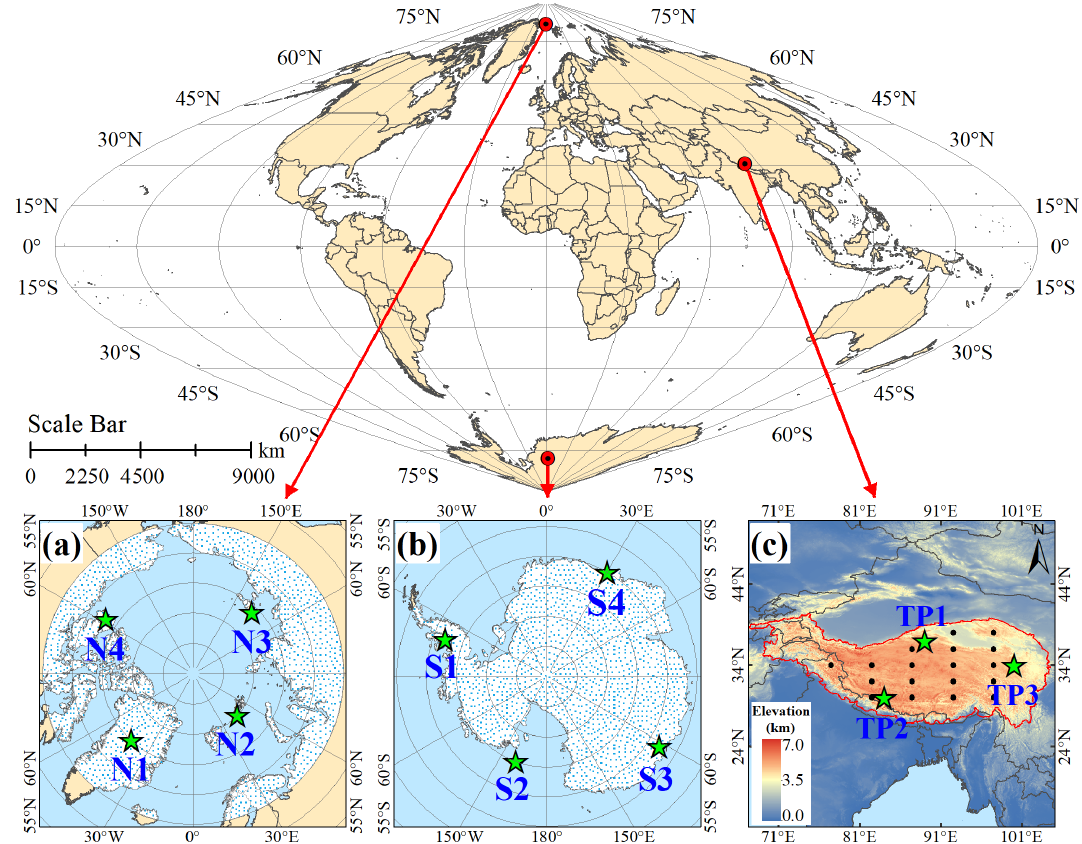
Figure 1. Geographical map of the three study areas: the (a) Arctic, (b) Antarctic and (c) TP. Among them, the white background and blue points represent the land within the study area. In (c) , the black dots represent the center of the TP inner pixel corresponding to CALIPSO (Cloud–Aerosol Lidar and Infrared Pathfinder Satellite Observations) L3 aerosol data, the green pentagrams represent the site of the aerosol back trajectory study, the red line represents the boundary of the TP, and the color represents the surface elevation data from the Shuttle Radar Topography Mission (SRTM) at http://srtm.csi.cgiar.org/ (last access: 24 March